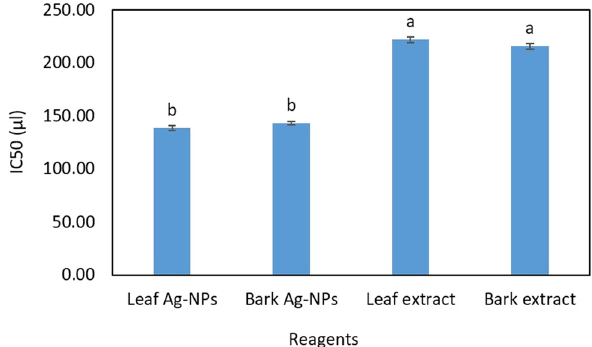
Figure 11: IC 50 value of Ag - NPs and